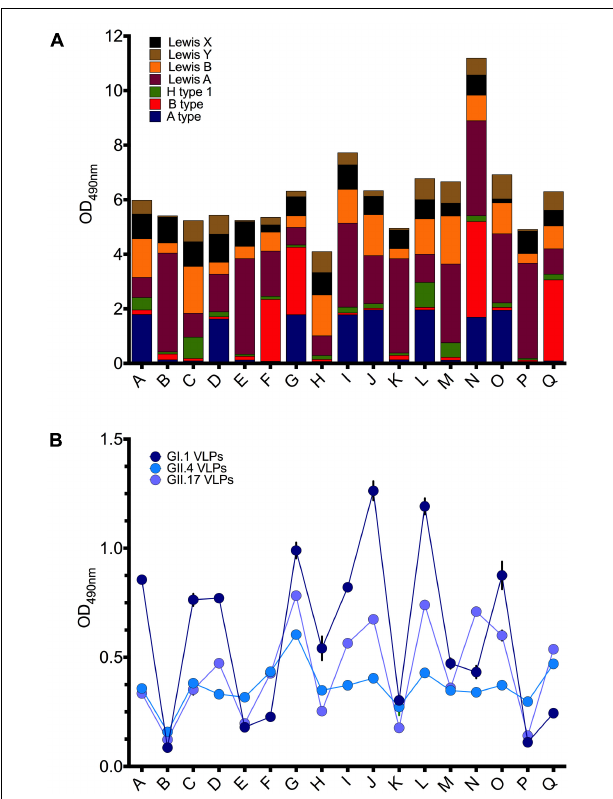
FIGURE 4 | Binding patterns of 20–2.5 µ g/ml (A) GI.1West Chester VLPs, (B) GII.4 Sydney VLPs to PAA-conjugated HBGAs synthetic HBGAs. Triplicate measurements for each VLP concentrations. Asterisks indicate statically significant differences (comparison to PBS control, p <